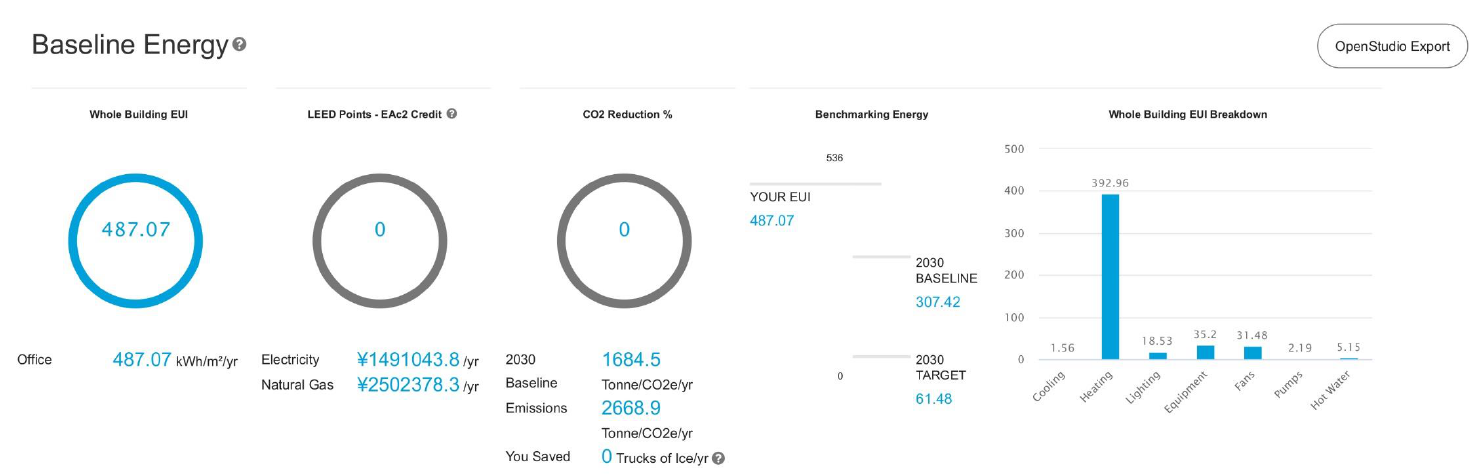
Clean Technol. 2022 , 4 , FOR PEER REVIEW Figure A33. Zone 6-A Changchun, Jilin (post-COVID-19 84% scenario). Figure A33. Zone 6-A Changchun, Jilin (post-COVID-19 84% scenario).